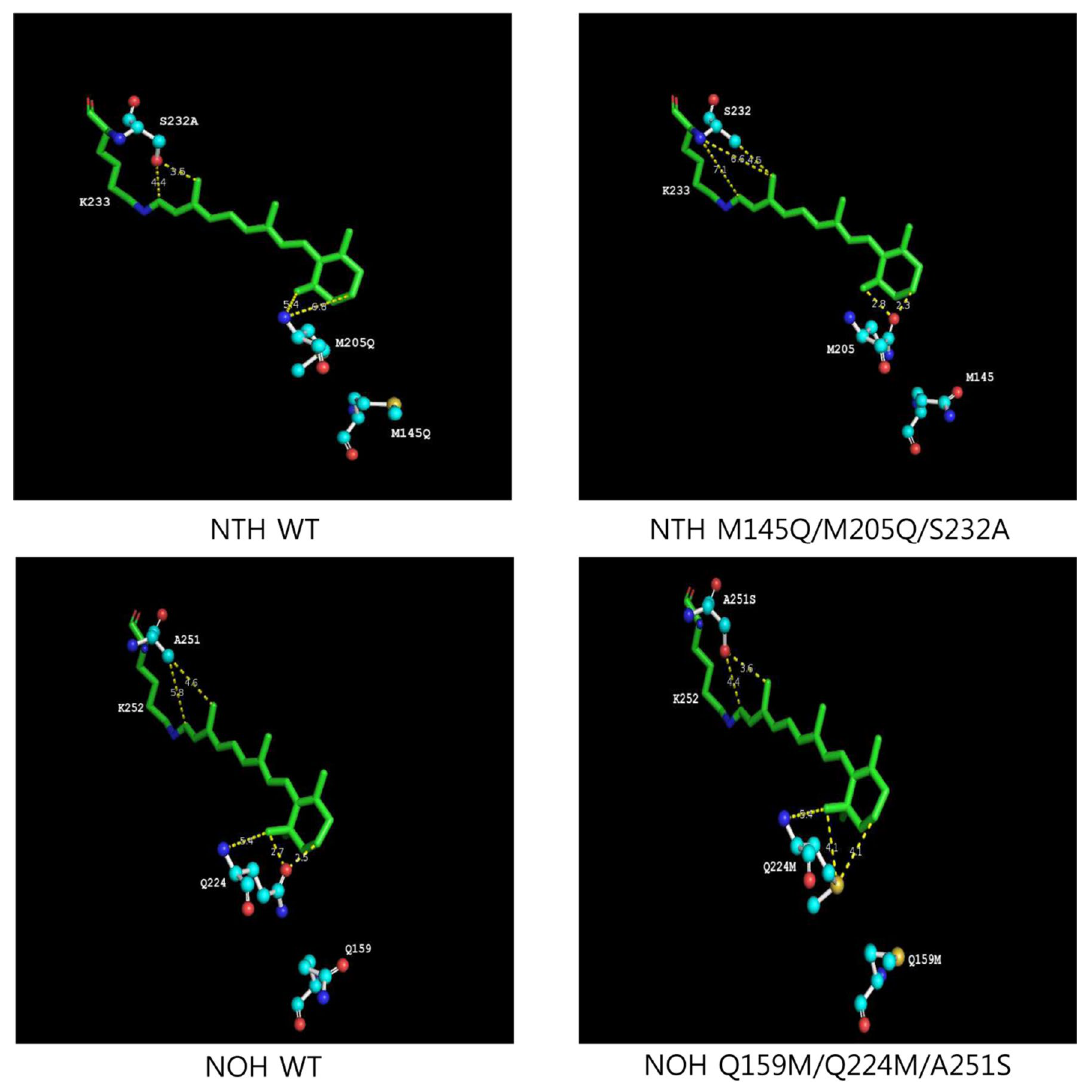
Figure 5. Local view of the residues involved in spectral tuning in N-terminal His-tagged Thermococcus heliorhodopsin (NTH) and N-terminal His-tagged Ornithinimicrobium heliorhodopsin (NOH) with computer modeling. The distance on both sides of the retinal chromophore (Schiff base side and β-ionone ring side) is changed along with mutant. For the NOH, the distance between β-ionone and Gln224 is greater when the Gln is replaced with Met. However, the distance of the Schiff base side of the chromophore becomes shorter when Ala is replaced with Ser. In the case of NTH, the prediction is reversed. Chromophore retinal is green, the amino group is blue, the O atom of COO - is red, the C atoms of amino acids are cyan, and S-methyl is